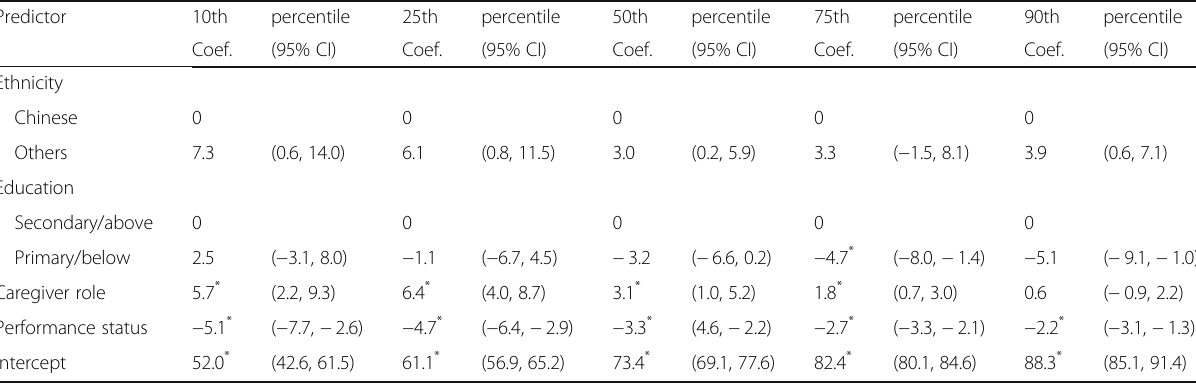
Table 3 Percentiles of QOL total score, final model Predictor